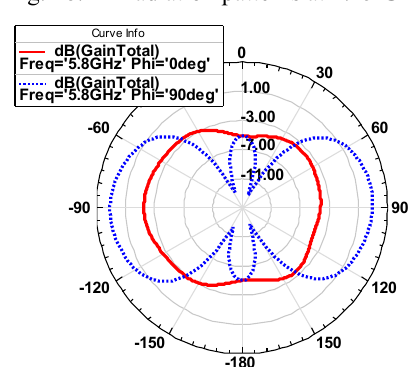
Fig. 19. 2D radiation patterns at 5.8